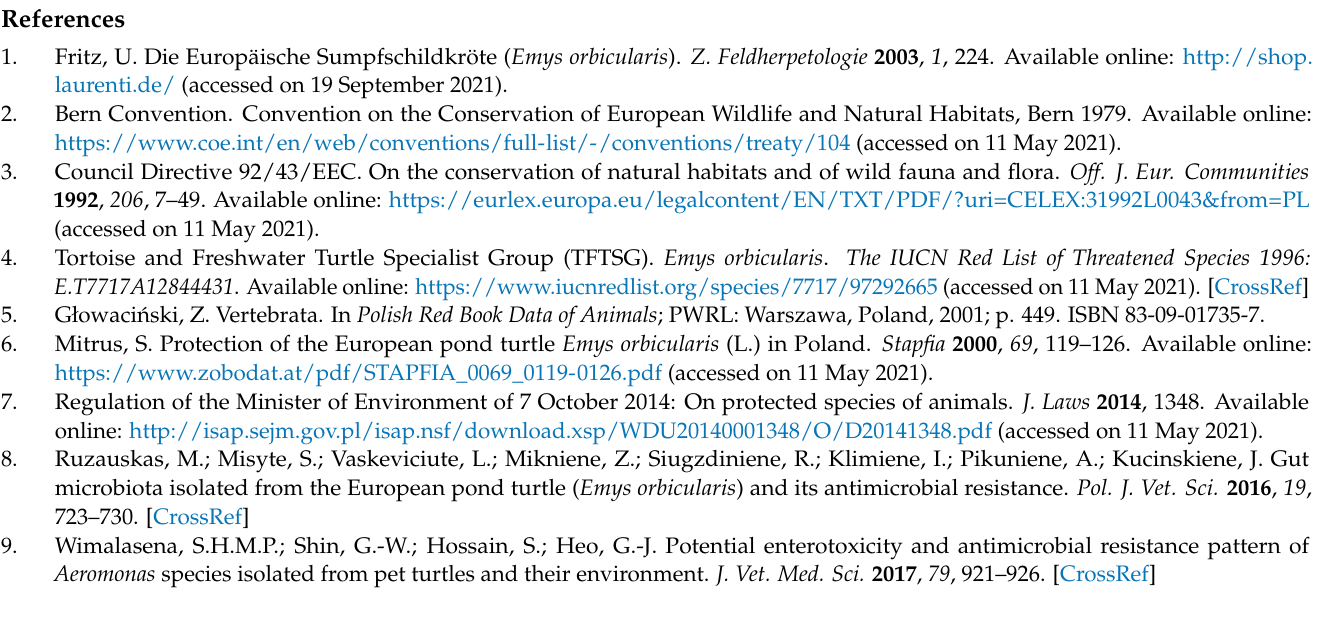
Table S2. Multiple Antibiotic Resistance Index of the Aeromonas spp.